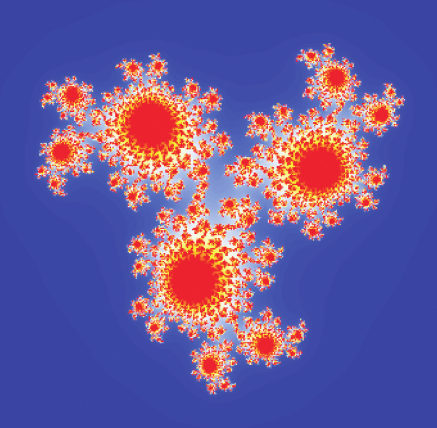
Figure 8: Cubic Julia set in